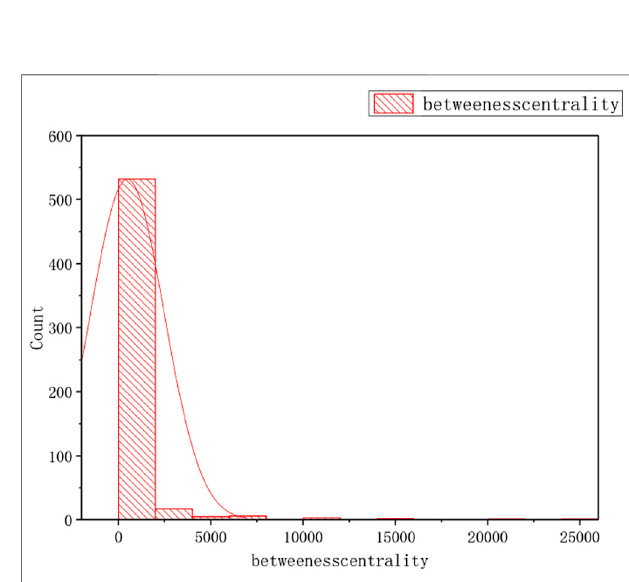
FIGURE 6 | The relationship between the degree and the weight degree of TOA Network: The linear relation between the degree and the weighted degree in TOA network is shown in this fi gure. After applying a linear fi tting method, an linear equation, y (cid:1) 4.28881 x − 3.34209, is plotted. Note that the Pearsons r , R -Square, Adj . R - Square are all greater than 0.5, meaning that this fi tting is quite appropriate.